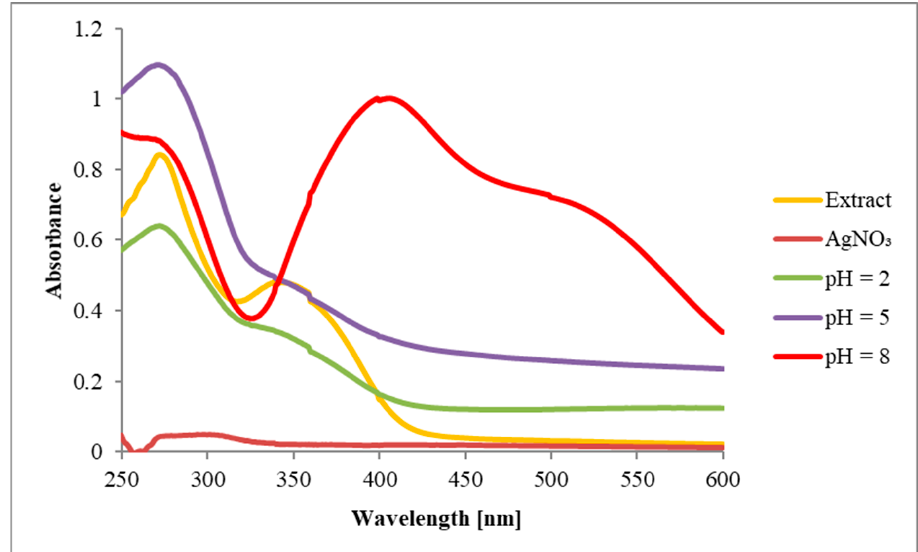
Figure 5. The influence of pH (2, 5, and 8) on AgNPs-H 2 O formation.